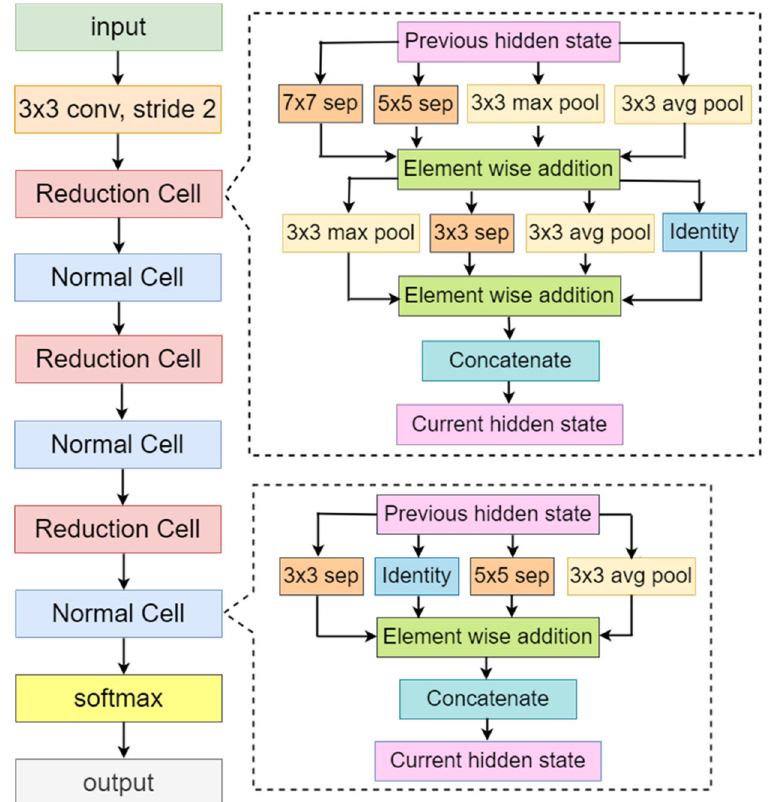
Figure 10. NASNetMobile architecture.